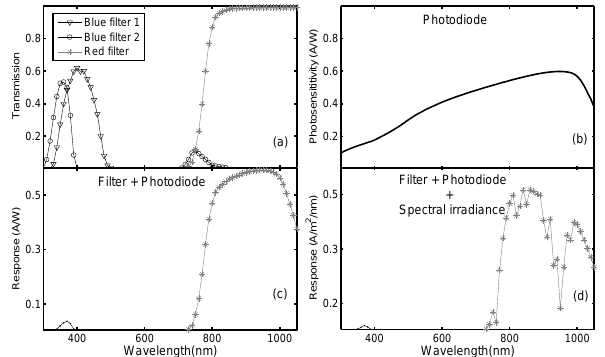
Figure 3. (a) Blue- and red-filter transmission. (b) Photodiode spectral response. (c) Response of filters–photodiodes combination. (d) Final blue-channel response (370µm ± 20µm) on the left and red-channel response (902µm ± 169µm) on the